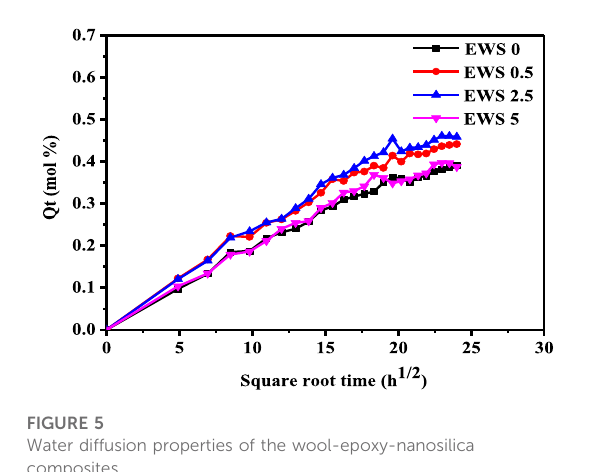
FIGURE 5 Water diffusion properties of the wool-epoxy-nanosilica